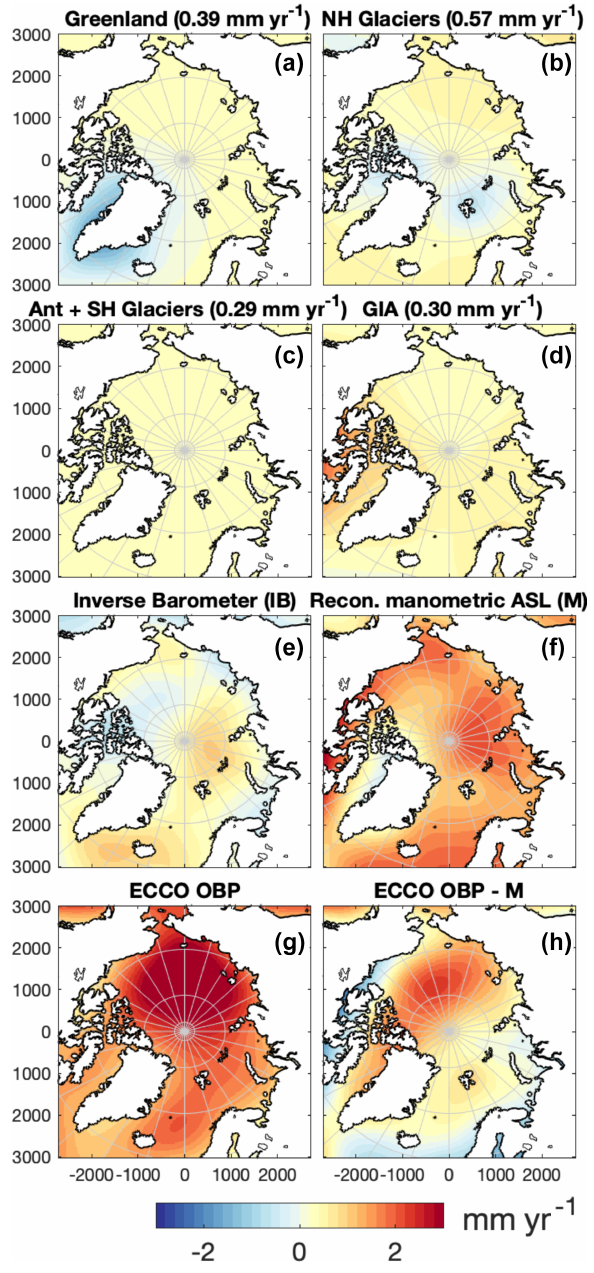
Figure 5. Contributions to the Arctic manometric sea level trend [mmyr − 1 ] from 1995–2015. (a–d) ˙ N (Eq. 4) for different sources of land-to-ocean mass changes with the global mean sea level contribution ( ˙ c ) written in brackets: Greenland (incl. peripheral glaciers) (a) , Northern Hemisphere (NH) glaciers (b) , Antarc- tica (Ant) + Southern Hemisphere (SH) glaciers (c) , and GIA (d) . (e) The estimated inverse barometer trend. (f) The sum of (a–e) and hence the total reconstructed manometric sea level trend. Modeled OBP estimate from ECCOv4r4 (Fukumori et al., 2019) (g) . The dif- ference between (g) and (f) is illustrated in panel (h)